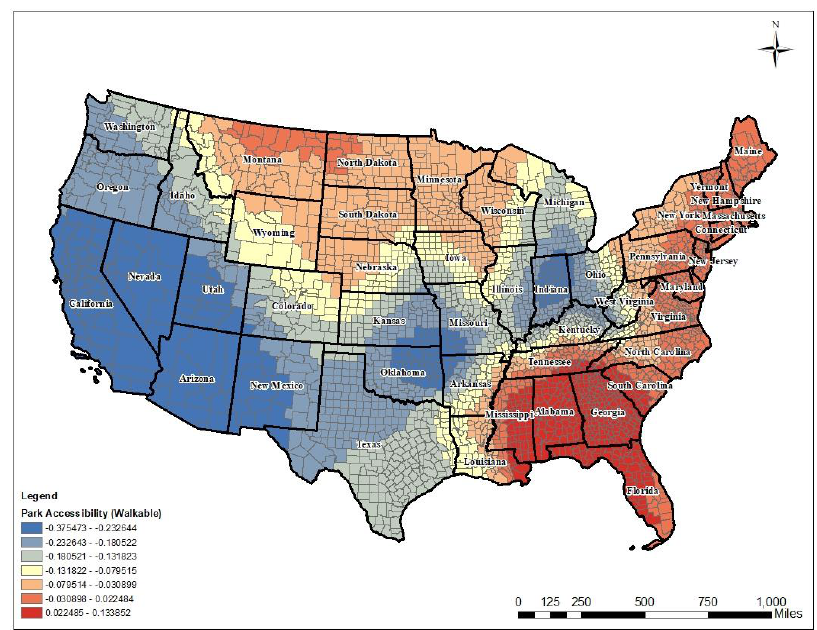
Figure 4. Local coefficients of park walkability. Figure 4. Local coe ffi cients of park